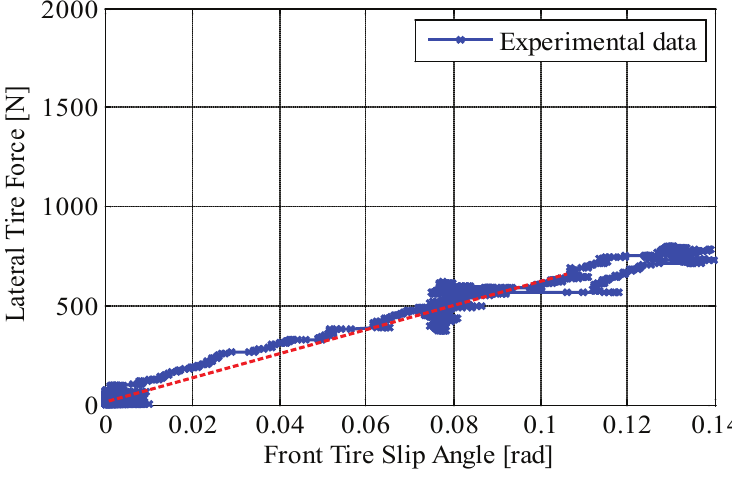
Figure 14. Front tire cornering stiffness on a low- µ road ( µ (cid:39) 0 . 3 ): relationship curve between measured lateral tire force and measured tire slip